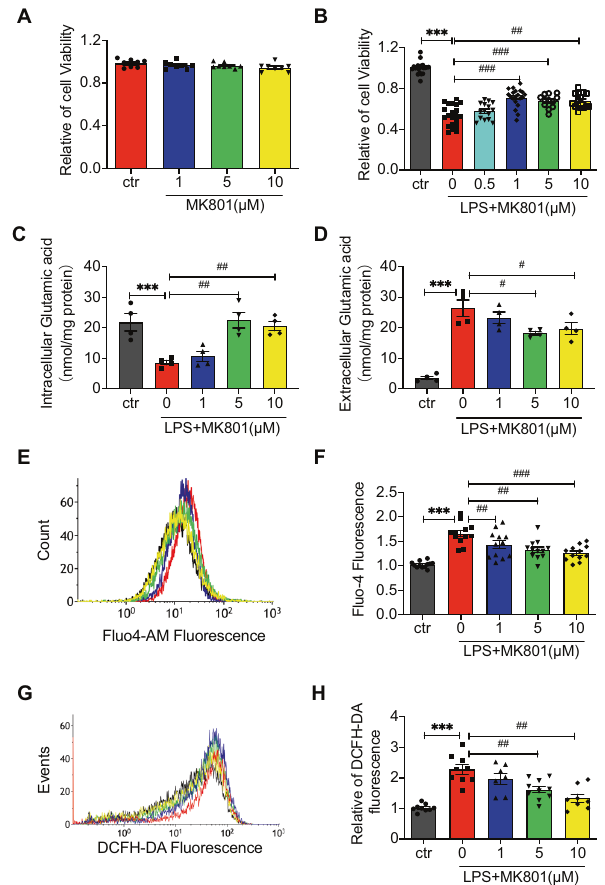
Fig. 1 MK801 protects against LPS-treated HUVECs. A MTT assay showed MK801 (1, 5, 10 μ M) did not affect cell viability in HUVECs. B MTT assay showed MK801 (1, 5, 10 μ M) effectively countered viability reduction induced by LPS (20 μ g/ml). C Intracellular glutamate and D extracellular glutamate concentrations in HUVECs after treatment with LPS (20 μ g/ml) for 24 h in the absence or presence of MK801(1, 5, 10 μ M). E Flow cytometry graphs and F analysis of Ca 2 + in fl ux in HUVECs with the fl uorescent probe Fluo- 4-AM in response to LPS (20 μ g/ml) and MK801 (1, 5, 10 μ M). G Flow cytometry graphs and (H) analysis of ROS production in HUVECs treated with LPS (20 μ g/mL) in the absence or presence of MK801 (1, 5, 10 μ M) for 24 h. (Data are presented as mean ± SEM, *** P < 0.001, ** P < 0.01, * P < 0.05 vs. Control; ### P < 0.001, ## P < 0.01, # P < 0.05 vs.